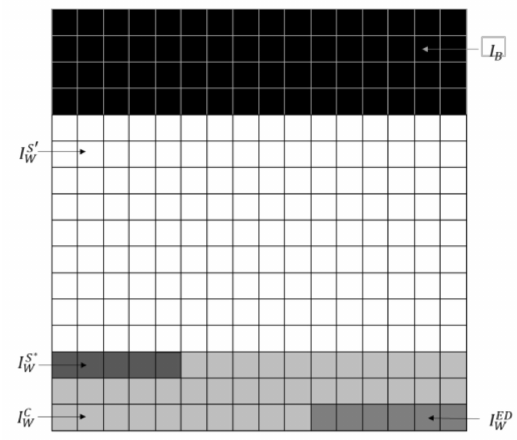
Figure 3. Rearranged vision of the original